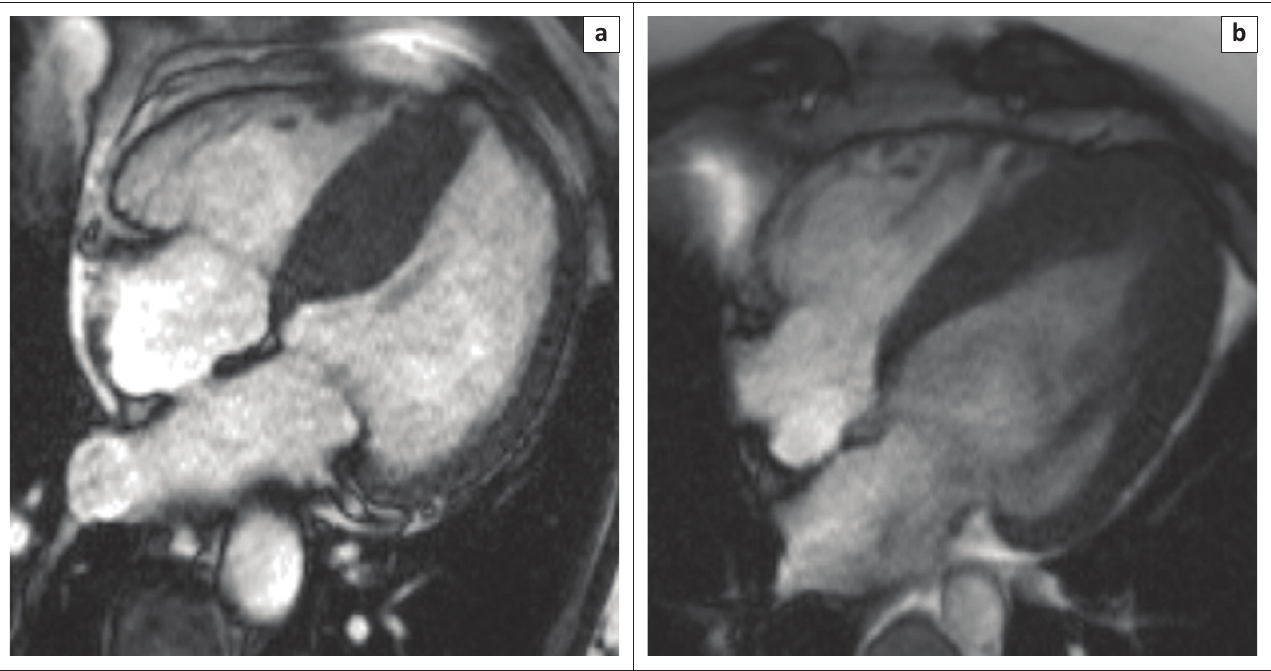
FIGURE 2: Asymmetrical septal hypertrophy seen on a four-chamber ciné. Shown are the end diastolic (just after mitral valve [MV] closure) frame (a), and the end systolic frame (b).